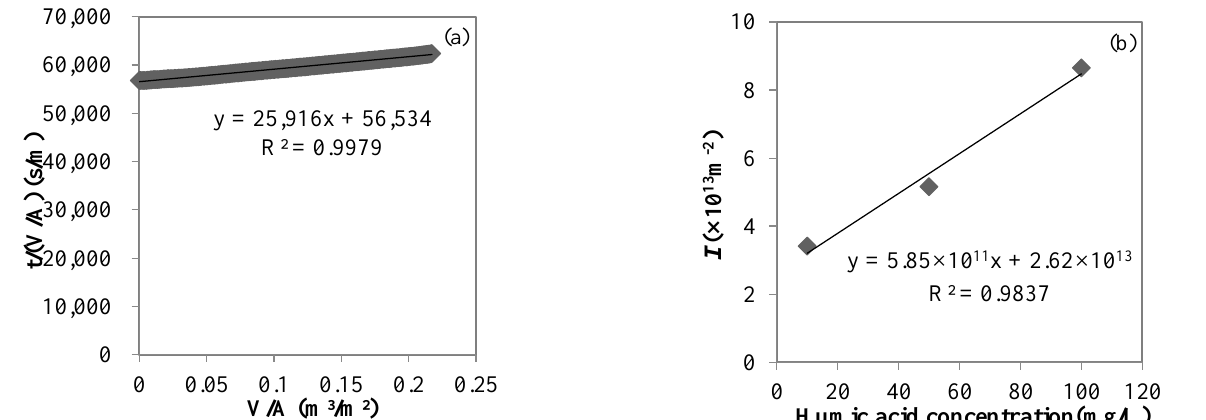
Figure 4. Cake layer model fitting for the UF process of a sodium alginate and bovine serum albumin (each 10 mg/L) mixed solution ( a ) and the correlation between I and the feed colloid concentration ( b ).